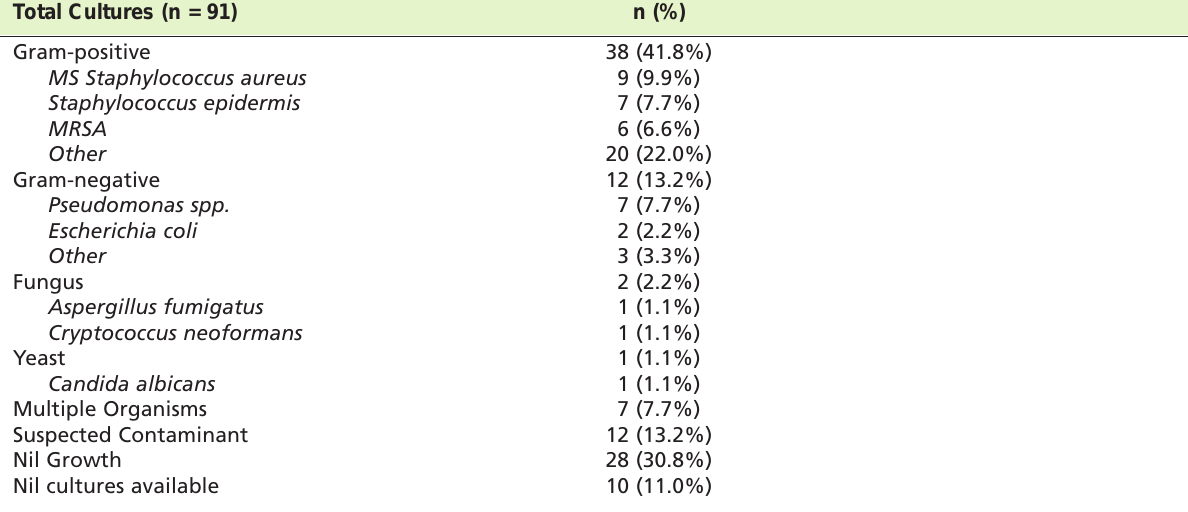
Microbiological profile of most recent culture of patients presenting to PJI MTD meeting Table II: